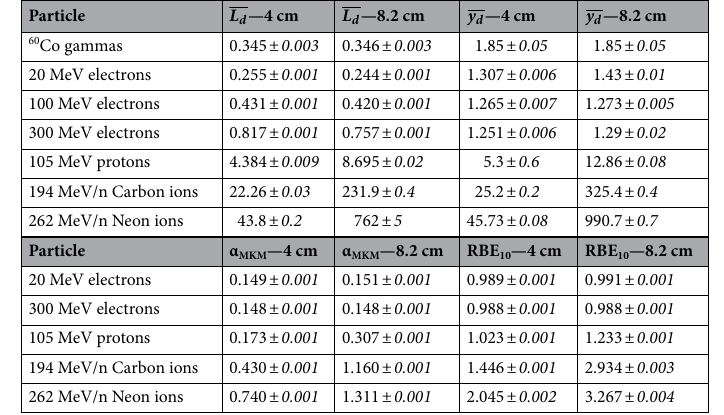
Table 1. Calculated values of L d and y d for all simulated particles of sufficient range, and of α MKM and RBE 10 for 20 MeV and 300 MeV electron, proton, carbon and neon ion beams at 4 and 8.2 cm in